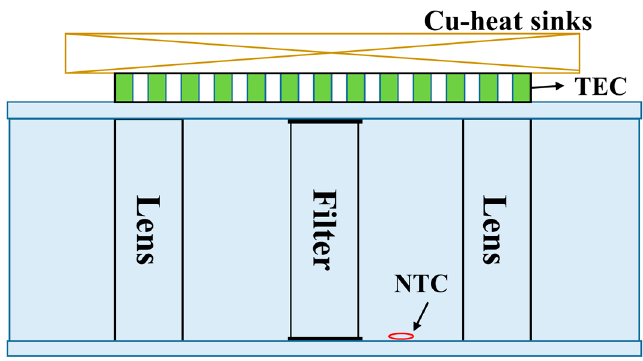
Figure 9. schematic diagram of filter temperature control.